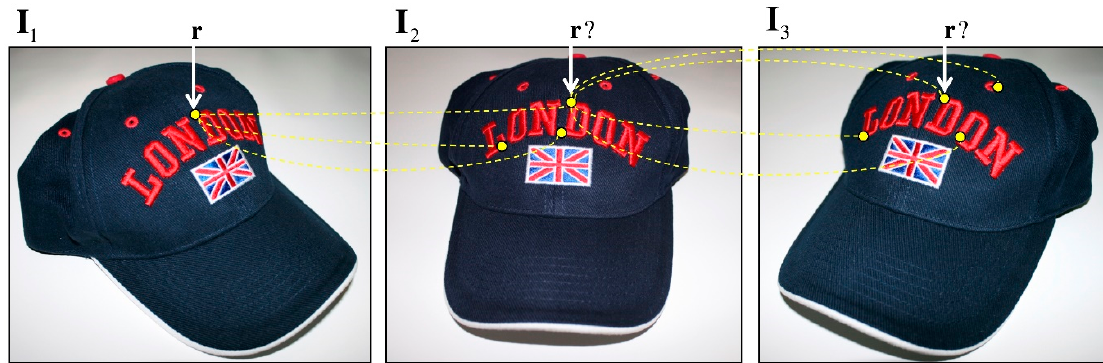
Figure 1. The point-matching problem in multiple views: determined a point r in I 1 , then we have to find the correspondences in I 2 and I 3 .